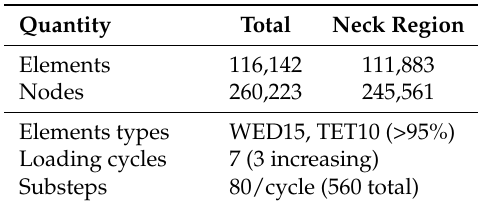
Figure 5. Numerical model of clamping/loading system of the fatigue machine. Table 3. Analysis detalies.